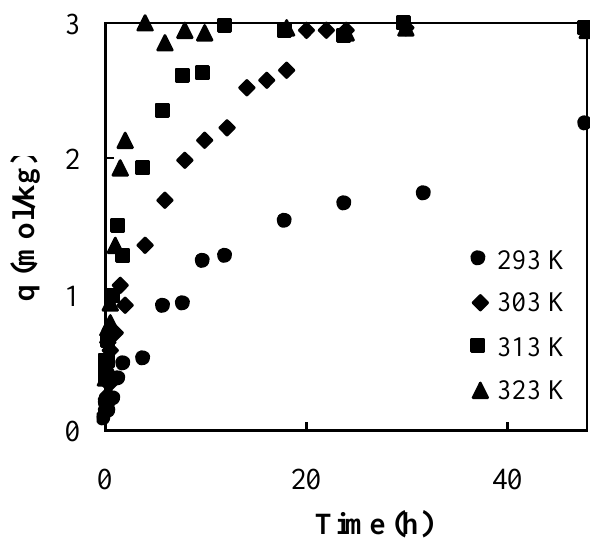
Figure 23. Time variation of the adsorption of gold(III) on CPT gel at different temperatures [33] (with permission for reuse from Elsevier